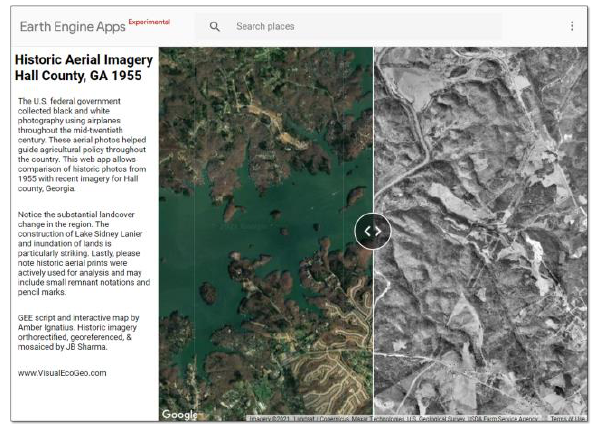
Figure 2. Google Earth Engine map application